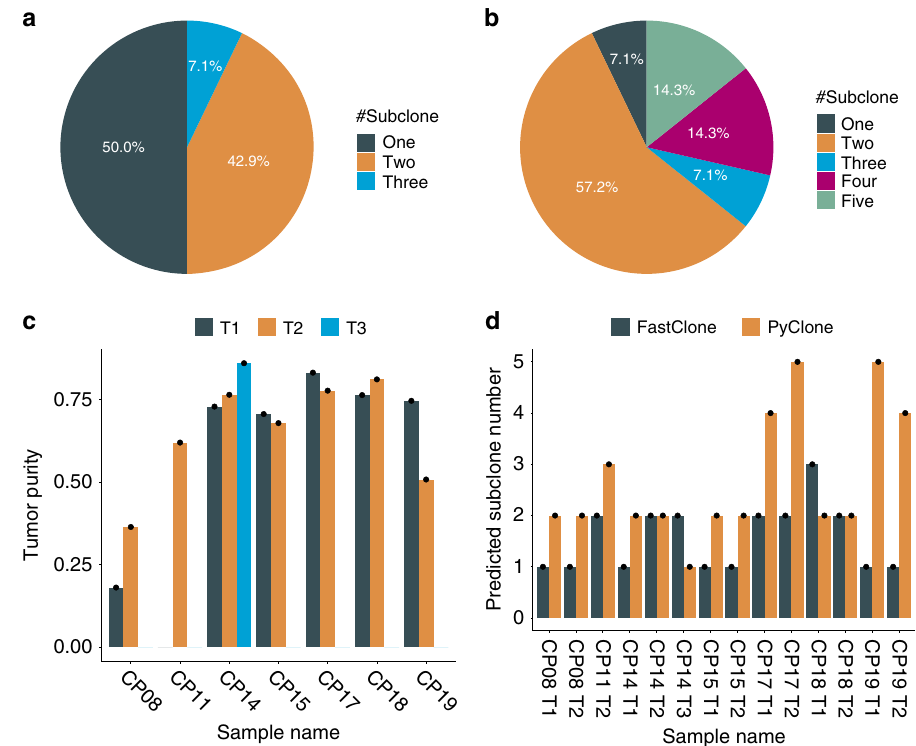
Fig. 4 Dissection of subclones in colon cancer samples. a FastClone ’ s result of the distribution of single and multiple subclones among primary tumor samples. b PyClone ’ s result of the distribution of single and multiple subclones among primary tumor samples. c The fi gure shows the tumor purity that is estimated by FastClone of each primary tumor sample. d The bar plot shows the comparison of FastClone to PyClone on predicting the number of subclones for each primary tumor